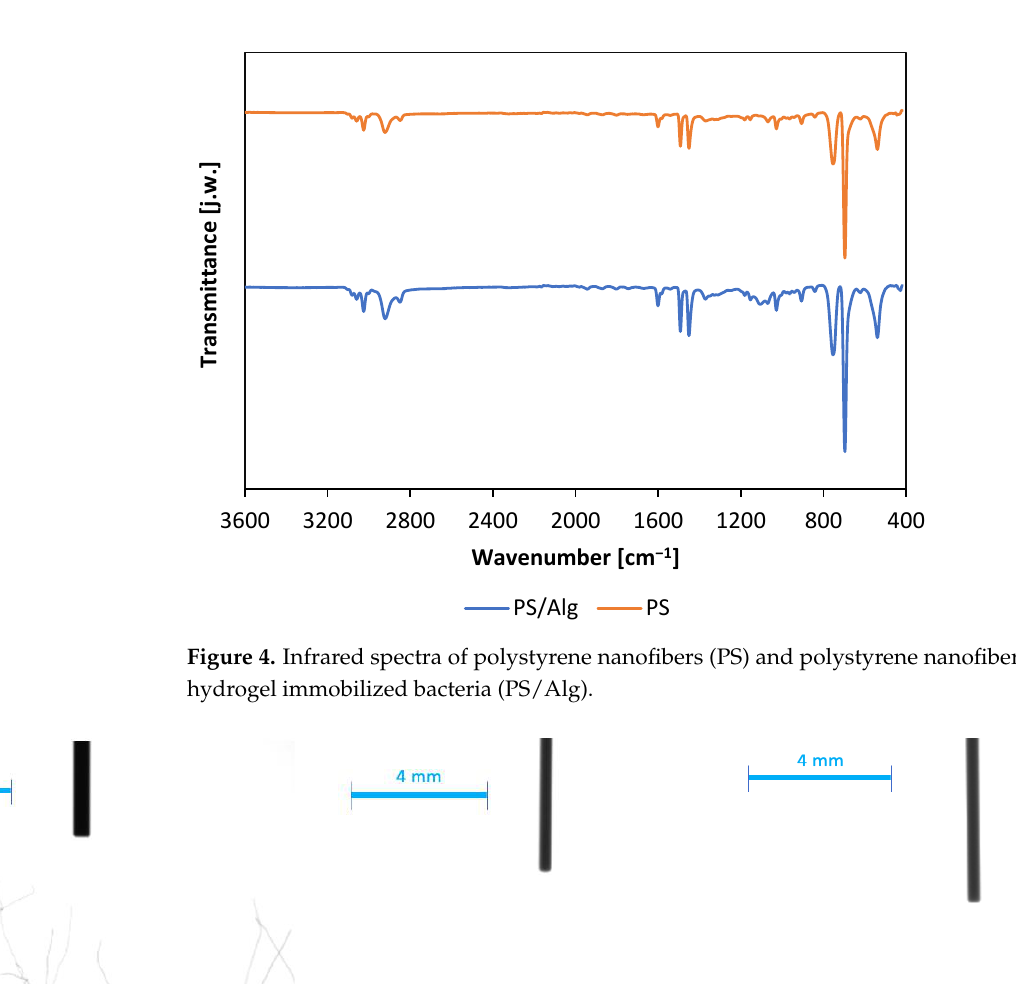
Figure 3. Top-view SEM pictures of PS nanofibers ( a ) and PS nanofibers with alginate immobilized bacteria ( b ) with a magnitude of 500.